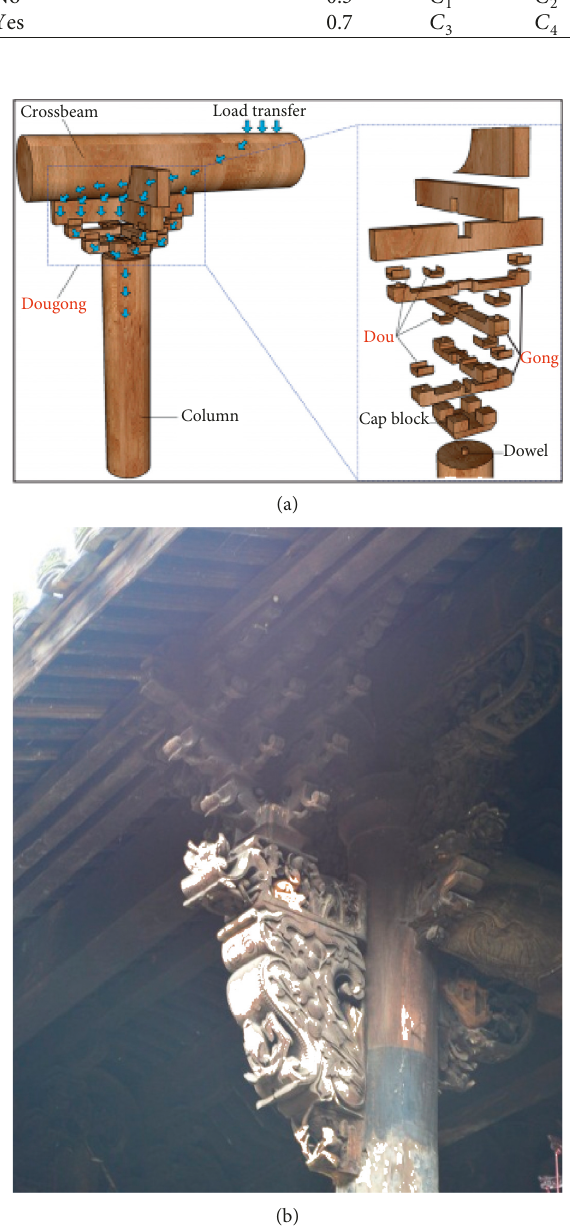
Figure 2: Dougong. (a) Structure of Dougong. (b) Dougong of Liben